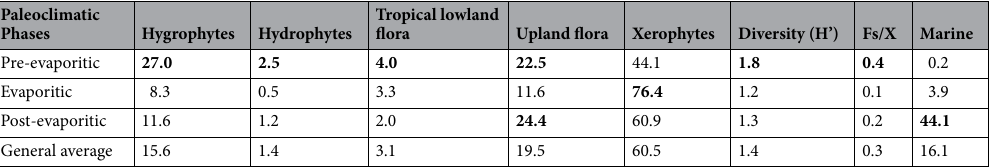
Table 1. Average abundance of bioclimatic groups, diversity, Fs/X and marine elements for the paleoclimatic phases. In bold, the most significant values. Numbers of bioclimatic groups (hygrophytes, hydrophytes, tropical lowland flora, upland flora and xerophytes) in average percentage. Numbers of marine elements in average absolute